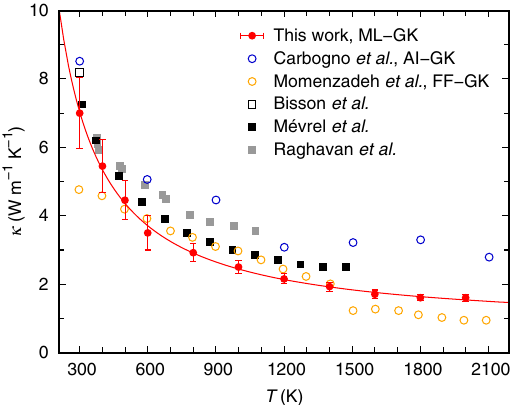
Fig. 6 Thermal conductivity of ZrO 2 as a function of temperature. The present results obtained using a MLFF and GK theory (ML-GK, red fi lled circles; the error bars are standard errors) are compared with previous theoretical results from GK theory combined with AI calculations (AI-GK, empty blue circles) 8 and an empirical force fi eld (FF-GK, empty orange circles) 54 . Experimental data from refs. 26,52,53 are shown as square symbols. The red line is a fi t to the present